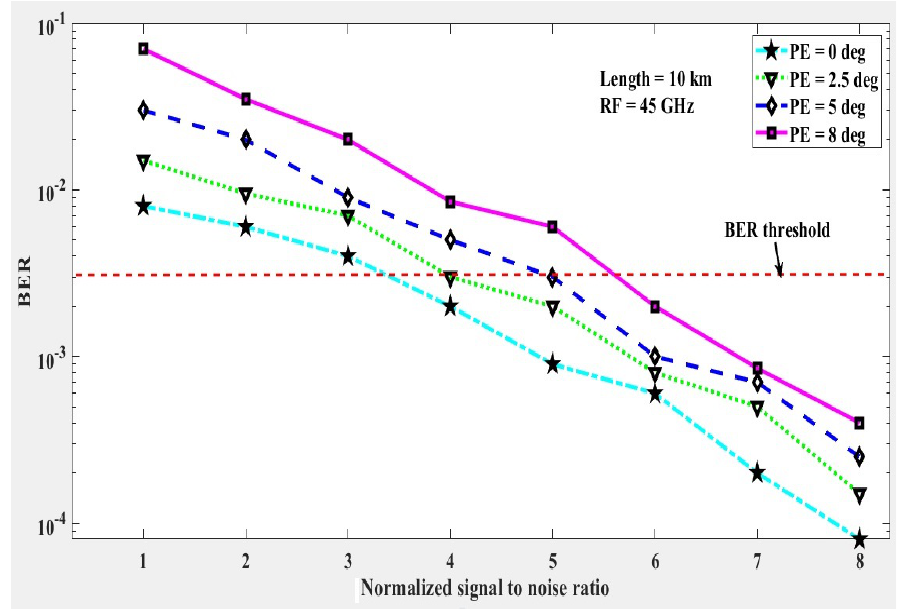
Figure 5. Normalized signal to noise ratio against BER for 0, 2.5, 5 and 8 deg PEs at 10 km of path